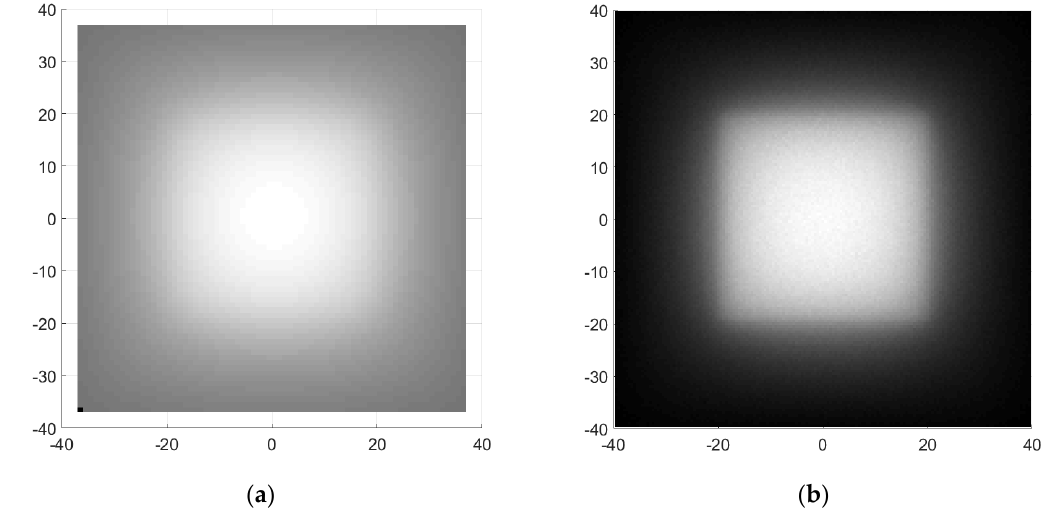
Figure 10. Normalized irradiance pattern of reflective system, detector located at z = 550 mm: ( a ) flowline computation; ( b ) raytrace computation.